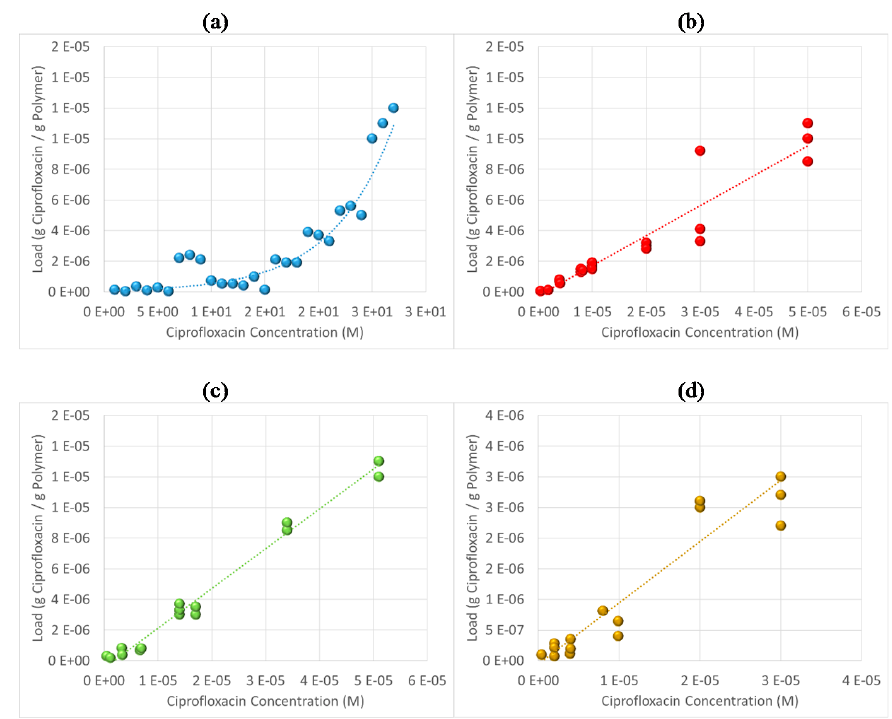
Figure 15. Adsorption isotherm charts for hydrogels synthetized by RAFT copolymerization. Samples: ( a ) G315; ( b ) G316; ( c ) G317; and ( d )